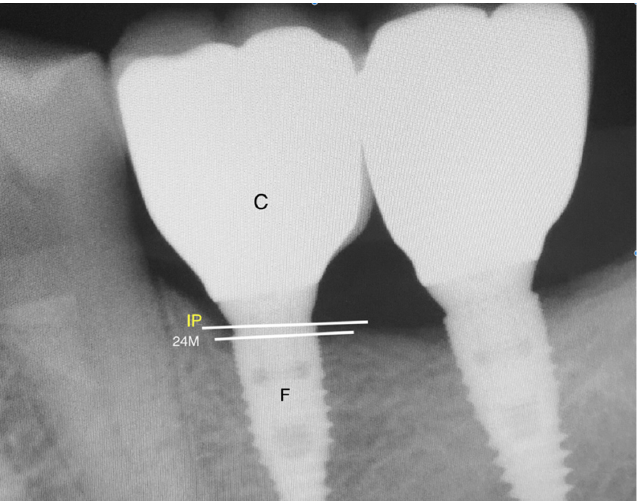
Figure 2. A periapical digital radiograph at 24-month recall; F, implant fixture; IP, implant peak; C, crown; 24M, bone level at 24-month recall visit.